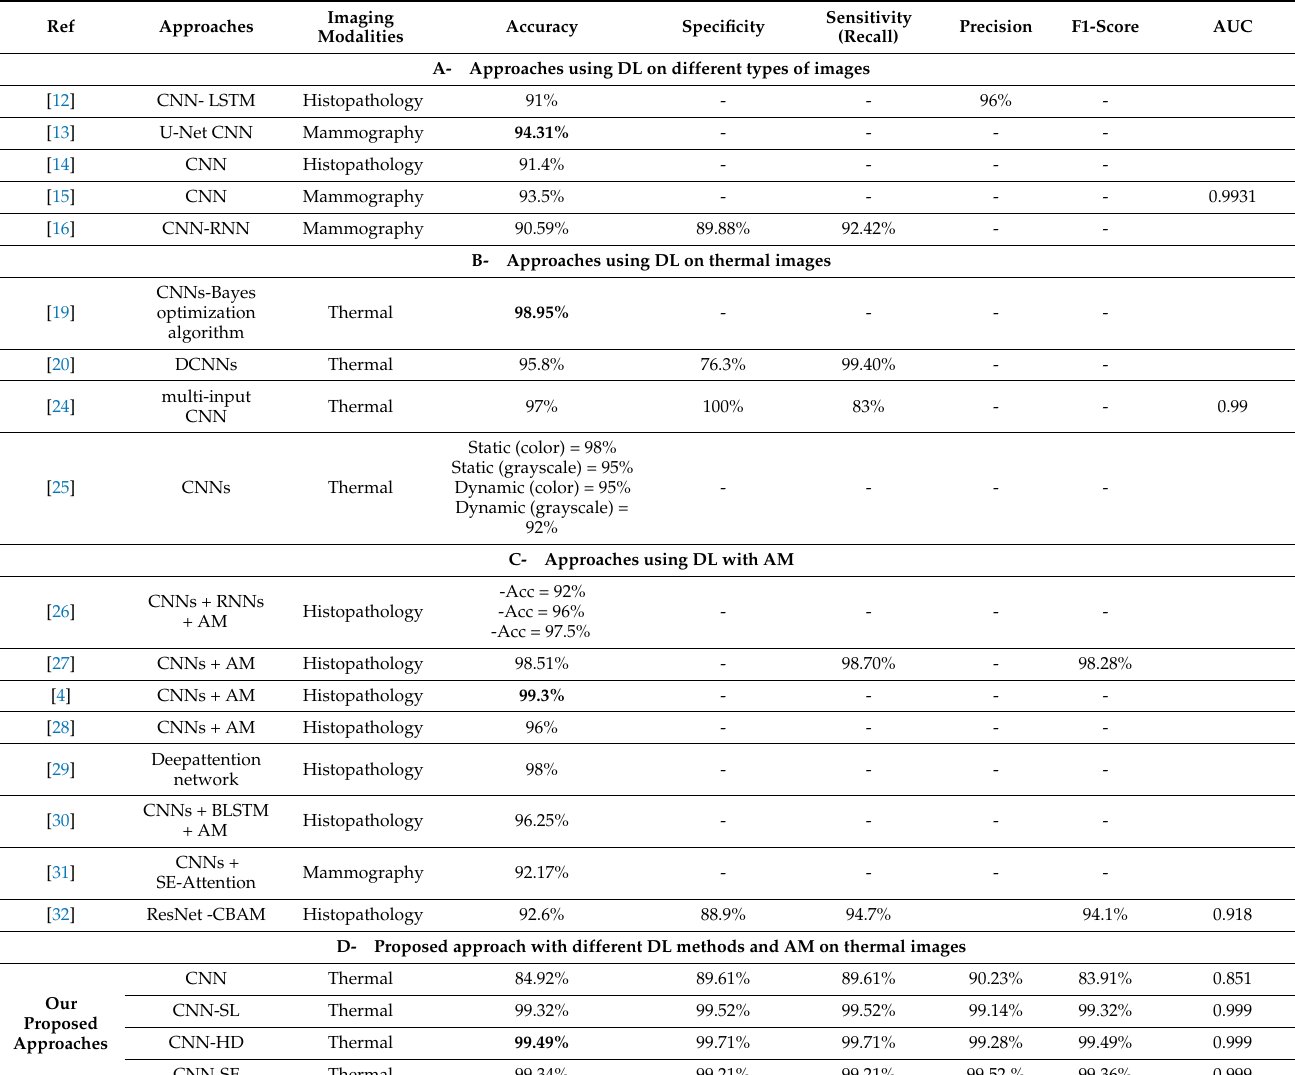
Table 4. Comparison of the performance results of all